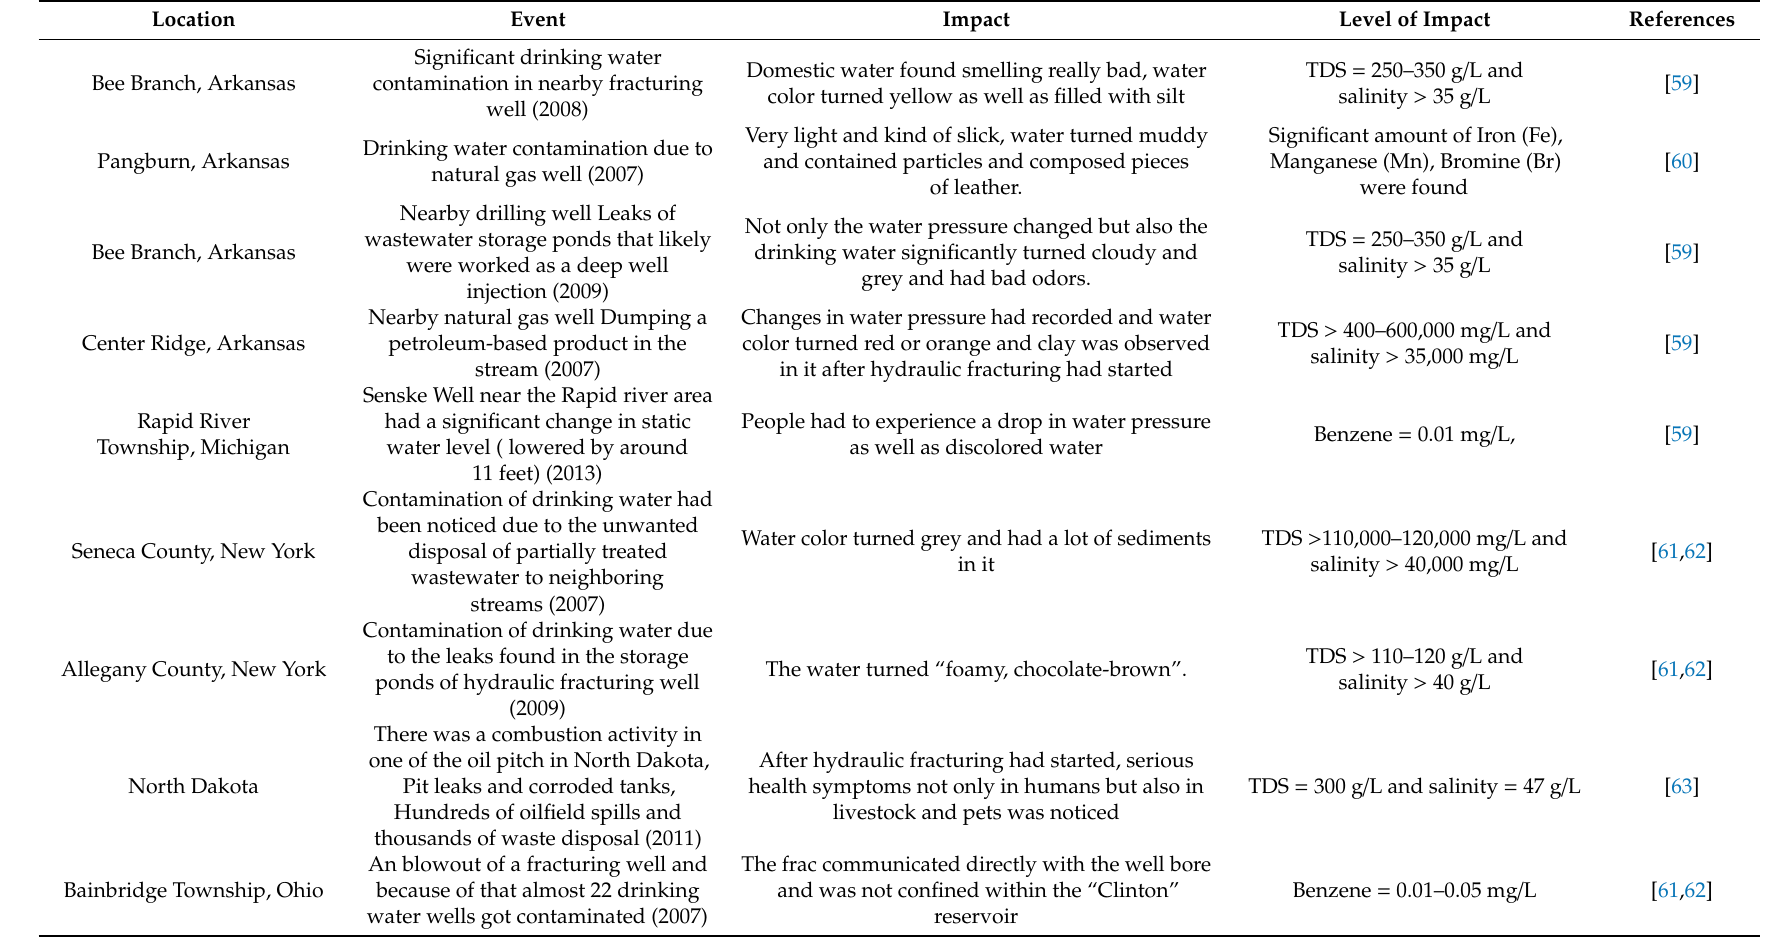
Table 2. Surface water